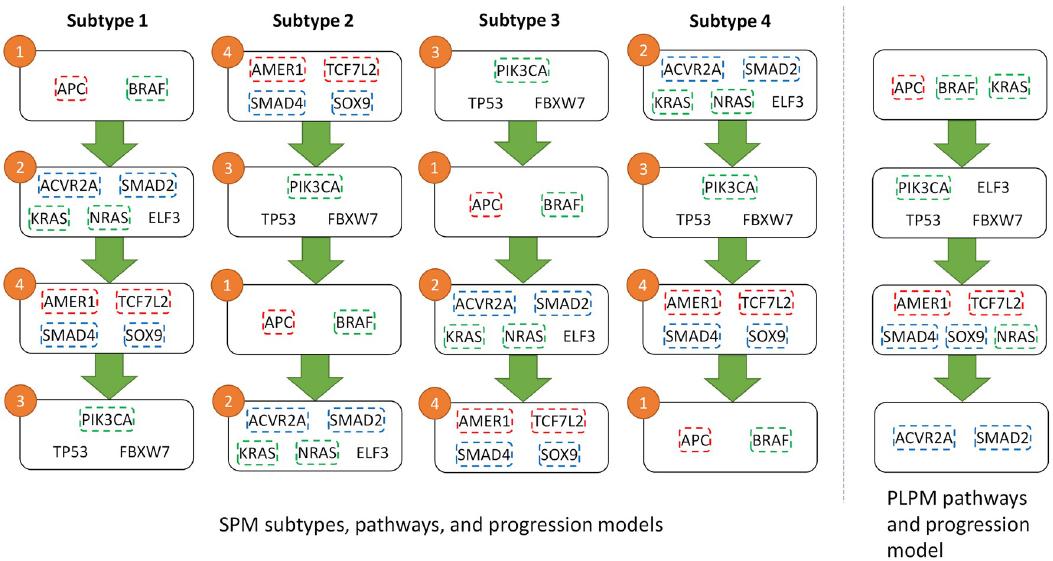
Fig 6. Pathways detected for COAD using SPM (left) and PLPM (right). Genes within the same known pathway are coded by the same color. The numbers on pathways refer to the pathway numbers in Fig 5.